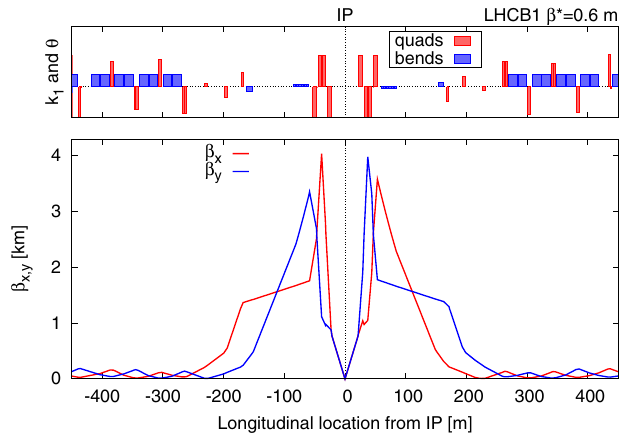
FIG. 1. Layout of the main interaction region (top) and (cid:1) functions (bottom) versus longitudinal location from the IP for (cid:1) (cid:1) ¼ 0 : 6 m .